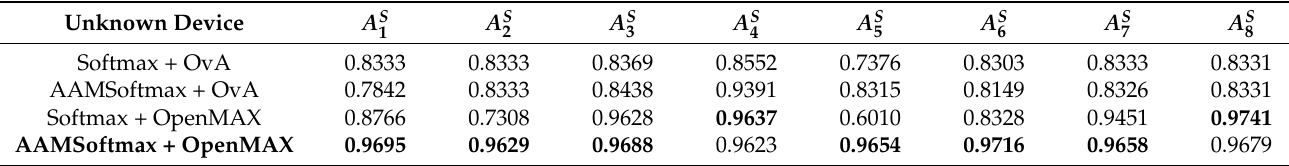
Table 3. The F 1 scores of different